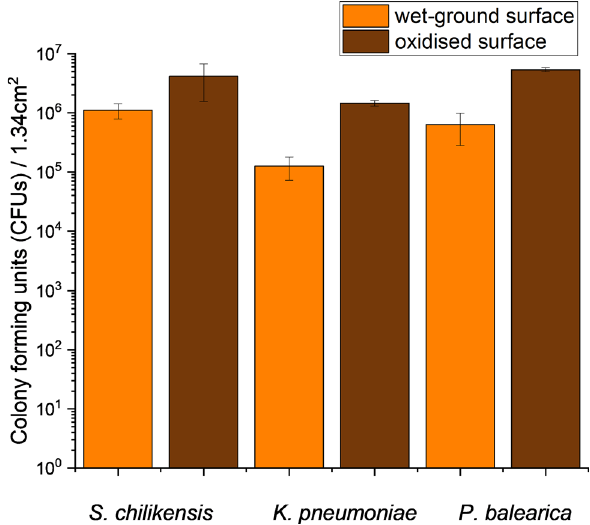
Figure 3. Direct cell quantification performed on oxidised surfaces and wet-ground surfaces after 24 h of exposure. Results are based on triplicate surface counts for each microorganism and surface type, and are expressed as CFUs per 1.34 cm 2 . Error bars represent the standard deviation of